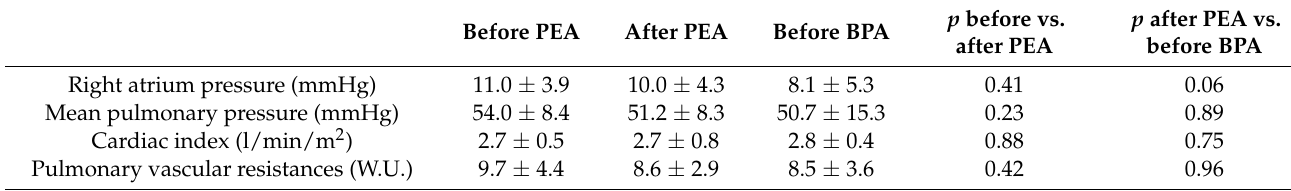
Table 2. Evolution of hemodynamic variables in post PEA patients ( n = 10). p before vs. p after PEA vs. Before PEA After PEA Before BPA